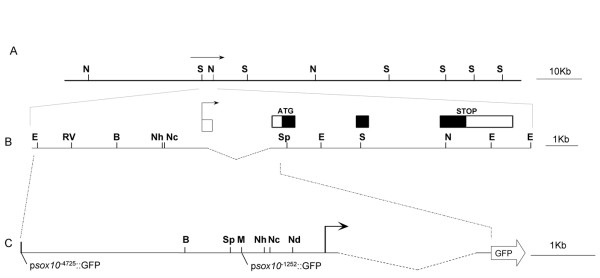
Genomic context of the zebrafish sox10 5' region used in sox10:GFP constructs. A. Restriction map constructed following partial sequencing of PAC BUSMP706I16137Q2 (RZPD) showing the location of DNA encoding sox10 (arrow). B. Genomic arrangement of sox10 coding region. The bent arrow shows the transcript start position. Closed boxes illustrate coding sequence and open boxes 5' and 3' untranslated regions. C. 5' upstream genomic region of sox10 used in construction of sox10:GFP plasmids. In B and C a dashed line indicates intron one. Start positions of psox10-4725:GFP and psox10-1252:GFP are indicated. B BamHI, E EcoRI, RV EcoRV, N NotI, M MluI, Nh Nhe1, Nc NcoI, Nd NdeI, S SmaI, Sp SpeI, Sh, SphI.